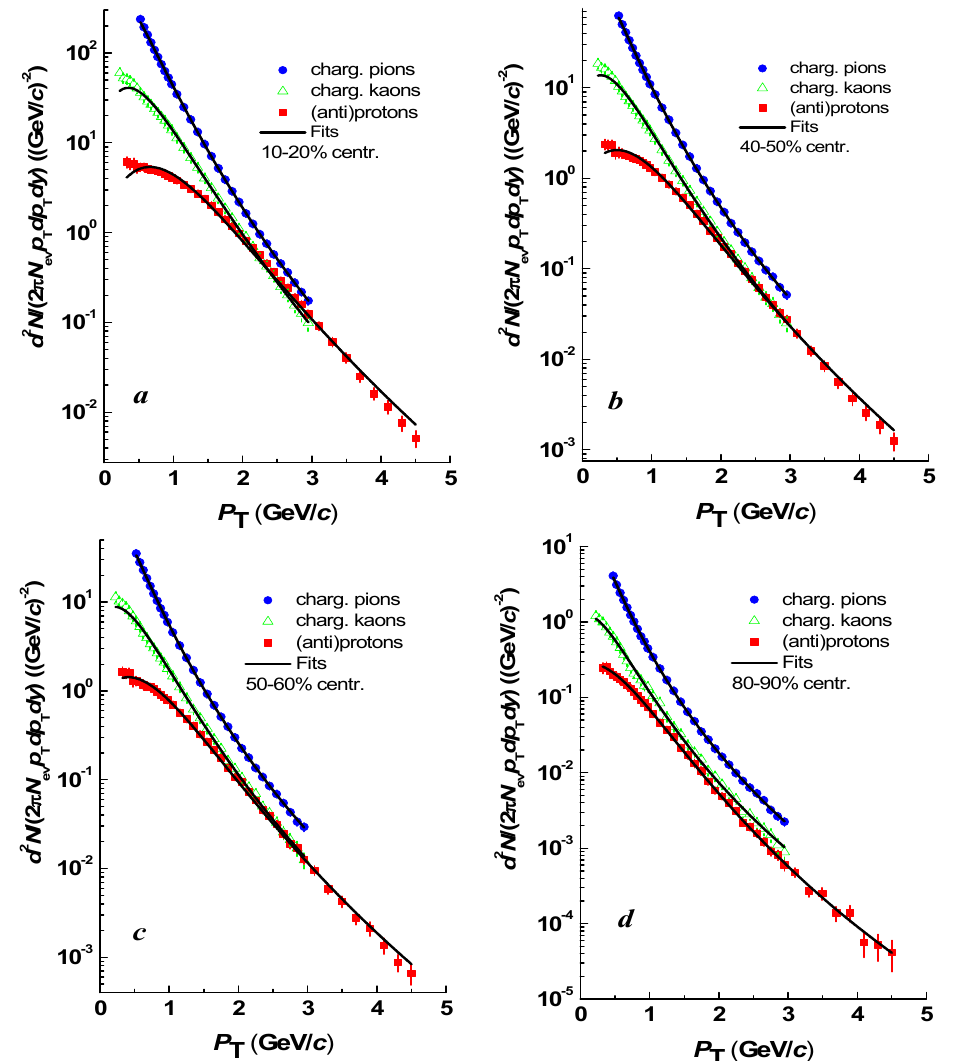
Figure 1. The resulting fit curves by Tsallis function with thermodynamical consistence with included transverse flow (Equation (5)) of the experimental midrapidity transverse momentum spectra of the charged pions ( • ), kaons ( ∆ ), and protons and antiprotons ( (cid:4) ) in Pb + Pb collisions at (cid:3493)𝑠 (cid:3041)(cid:3041) = 2.76 TeV at various centralities: 10–20% ( a ), 40 –5 0% ( b ), 50–60% ( c ), and 80–90% ( d ).